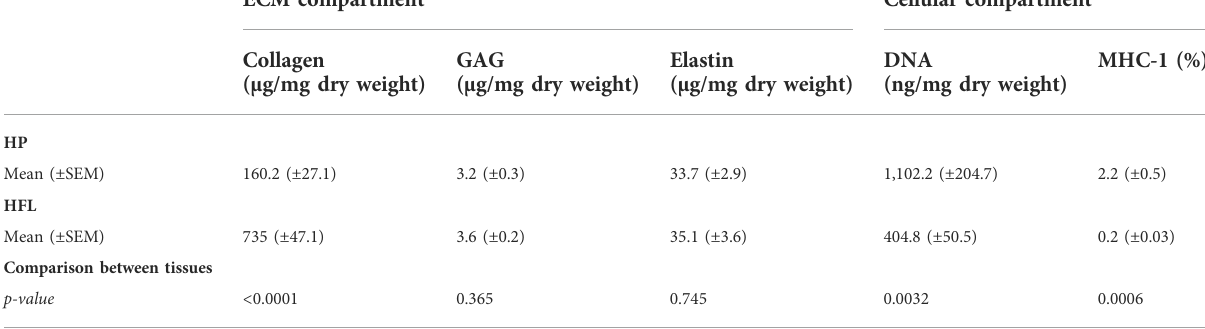
TABLE 1 Comparison of main quantitative data between both tissues ( N = 4 donors x three samples from each donor leading to n = 12 specimens analyzed for each quanti fi cation and for each tissue). HP: human periosteum, HFL: human fascia lata, SEM: standard error of the mean, MHC-1: major histocompatibility complex of type 1, GAG: